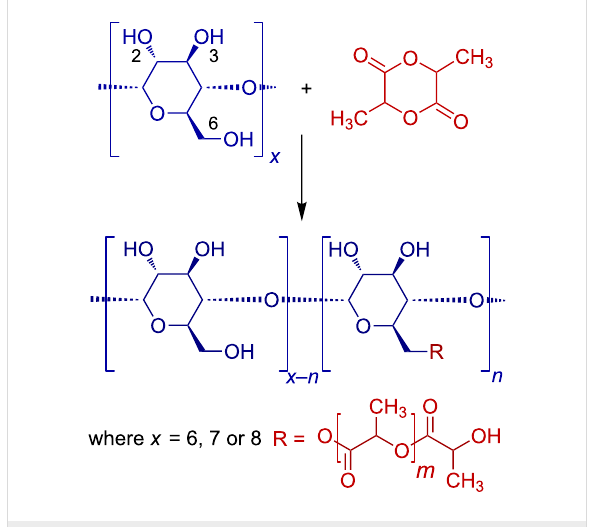
Scheme 1: Ring opening of L-LA in the presence of